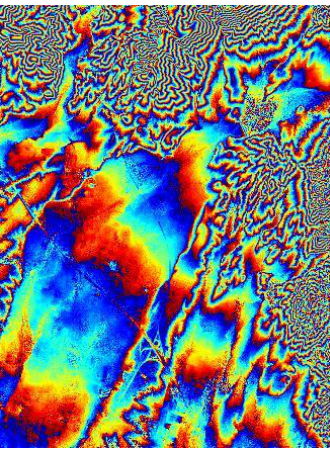
Figure 9. Interferogram after phase filtering with the multi-scale phase-filtering method in the wavelet domain.